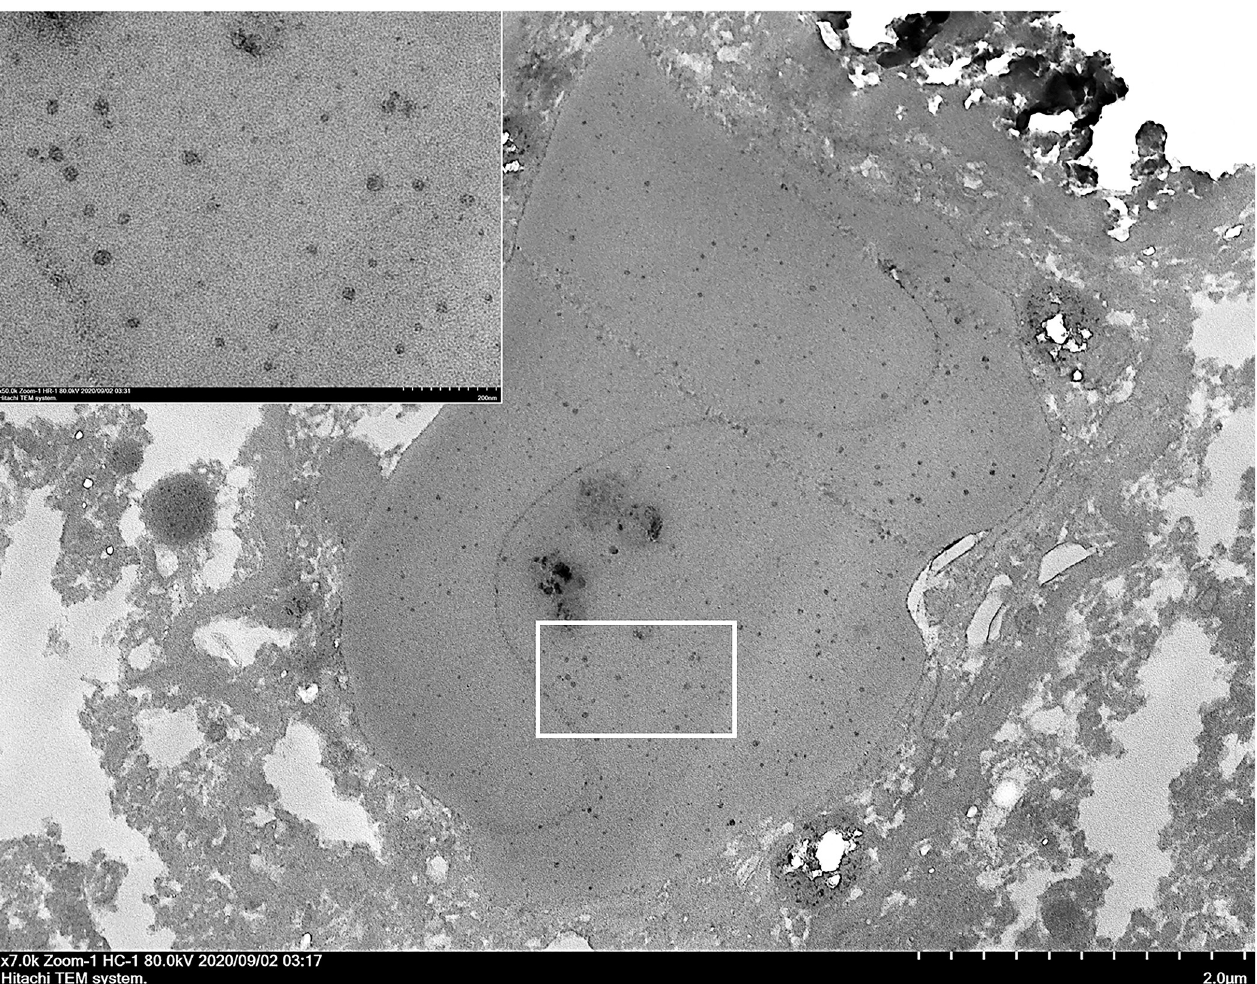
Fig 3. CBoV-2 infection in dog no. 241CP6, showing the ultrastructure of an infected brain. An oligodendroglia cell containing an inclusion body within the nucleus, which contained aggregates of electron-dense icosahedral virions (inset). Bar as indicated.